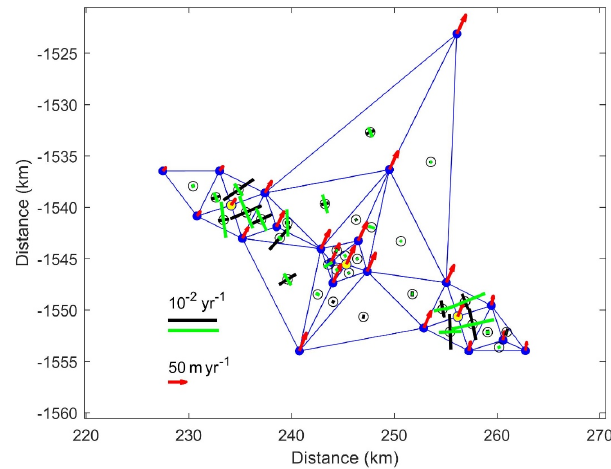
Figure 5. Horizontal principal strain rates for 32 different triangular sections within the GPS array. The principal strain rates are plotted at the centroids of each triangle (black circles) with black lines in- dicating positive strain rates (extension) and green lines indicating negative strain rates (compression). The GPS-derived surface veloc- ities (red arrows) are plotted at the stakes (blue dots). At three GPS stakes (yellow dots), strain rates along the direction of the flow are